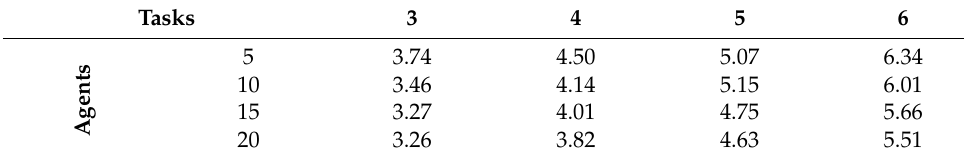
Table 6. Mean Improvement in Acceptable TBRM States per MAS (Scenario 2).